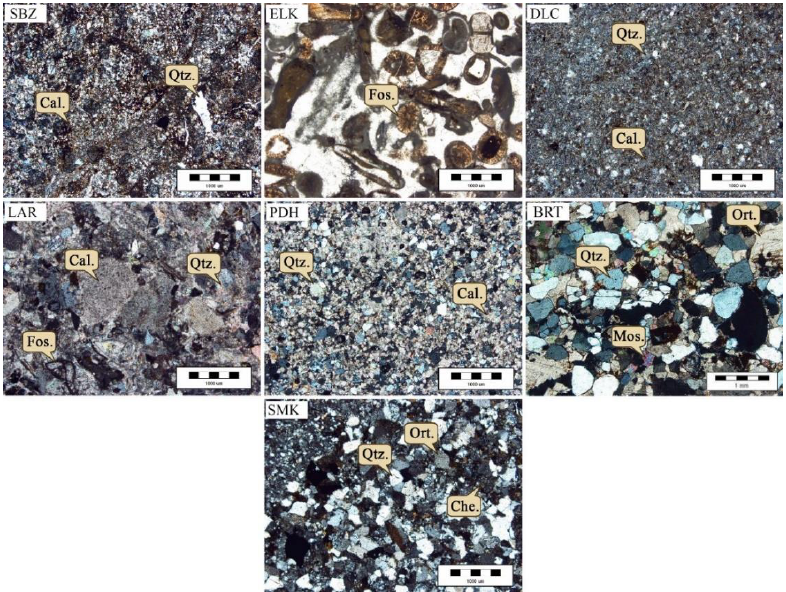
Figure 5. Microscopic images of the studied rock samples. ( Qtz.: Quartz (SiO 2 ); Cal.: Calcite (CaCO 3 ); Dol.: Dolomite (Ca.Mg(CO 3 ) 2 ); Fld.: Feldspar; Fos.: Fossil). Table 1. Mineralogical and petrographic properties of the studied rock samples.